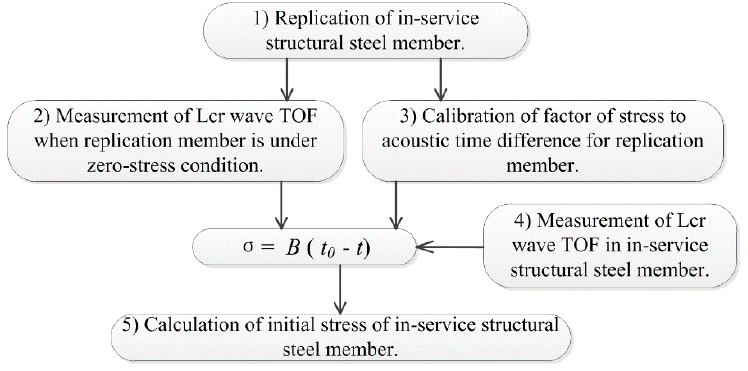
Figure 4. Flow chart of ultrasonic method.